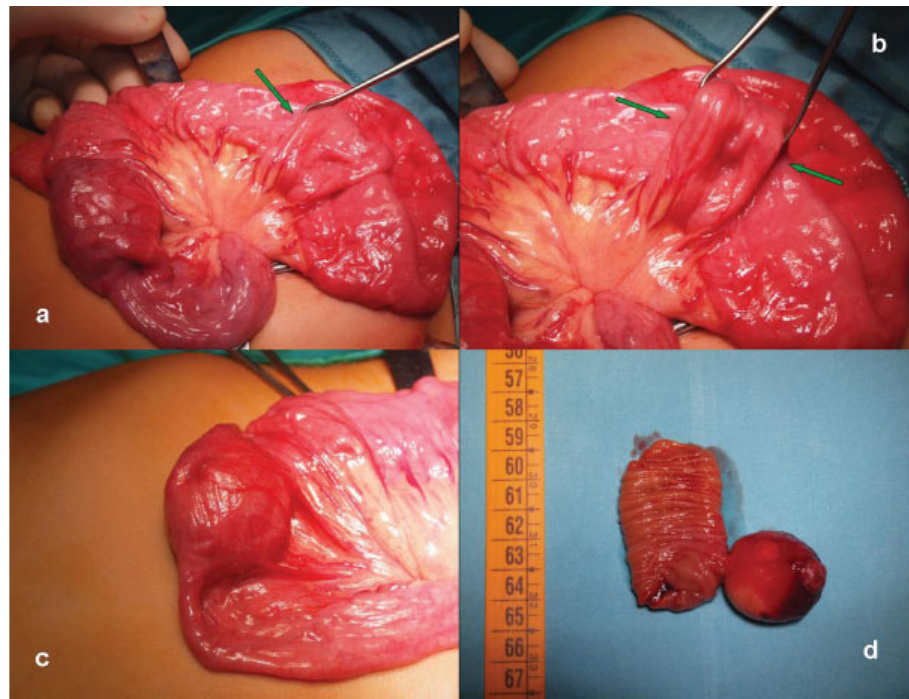
Fig. 3 (a, b) After the reduction of the fi rst compound intussusception, another compound intussusception was noted (c) far from the mass. (d) The resected tract showed an intraluminal